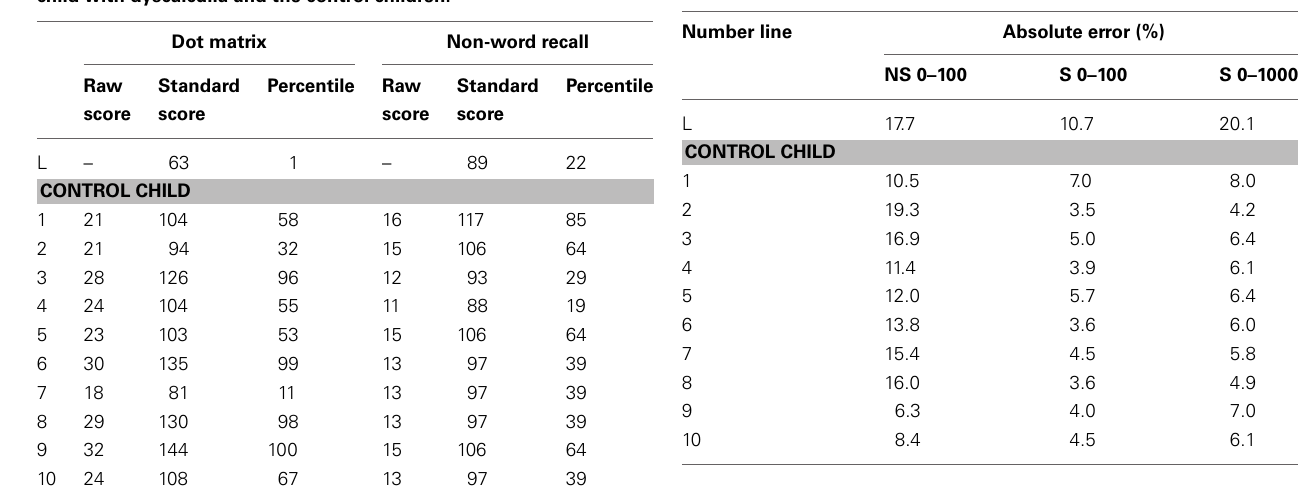
Table A3 | Overview of the individual mean percent absolute errors of the child with dyscalculia and the control children on the non-symbolic 0–100 and symbolic 0–100 and 0–1000 number line tasks.